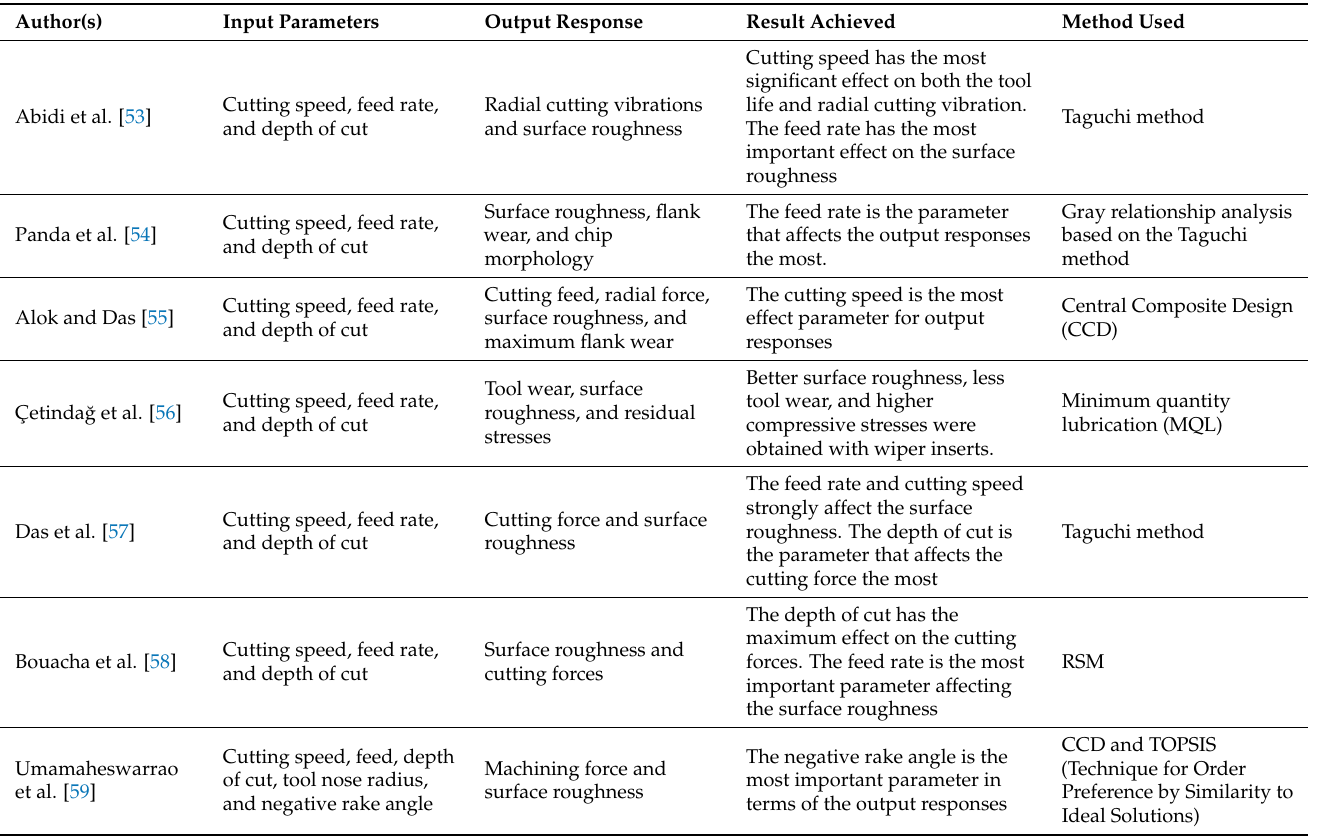
Table 2. A summary of studies on the optimization of the cutting parameters of AISI 52100 bearing